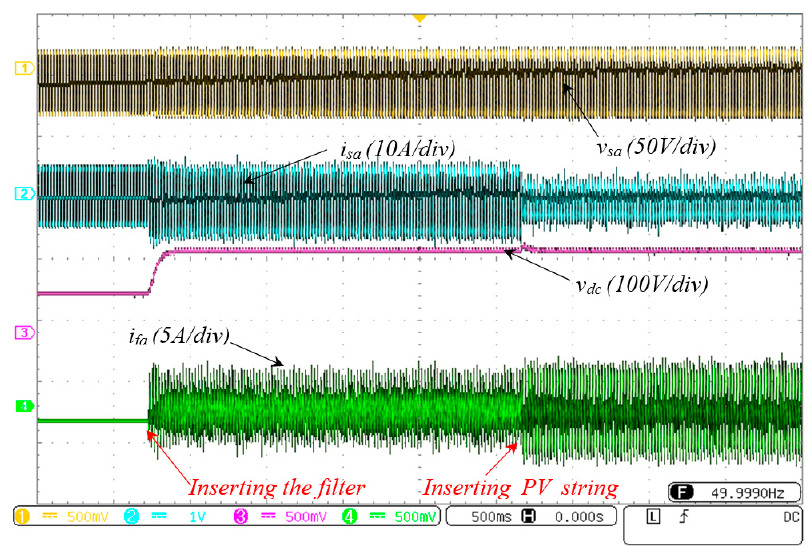
Figure 17. Obtained results in different scenarios.